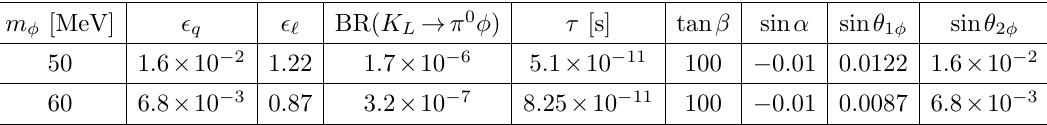
Table 1 . Benchmark points of the e(cid:11)ective model which satis(cid:12)es both the KOTO and ( g (cid:0) 2) (cid:22) anomalies. The benchmark with m (cid:30) = 50 MeV is indicated in (cid:12)gures 3 & 4 by a star. The benchmark with m (cid:30) = 60 MeV is indicated in (cid:12)gures 3 & 4 by a circle. The (cid:12)rst three columns are the three free parameters of the e(cid:11)ective model, and the fourth and (cid:12)fth columns are the second set of parameters if one trades the two e(cid:11)ective couplings for the Kaon decay branching ratio and (cid:30) lifetime. The last four columns give the corresponding values of tan (cid:12) and three mixing angles in the UV